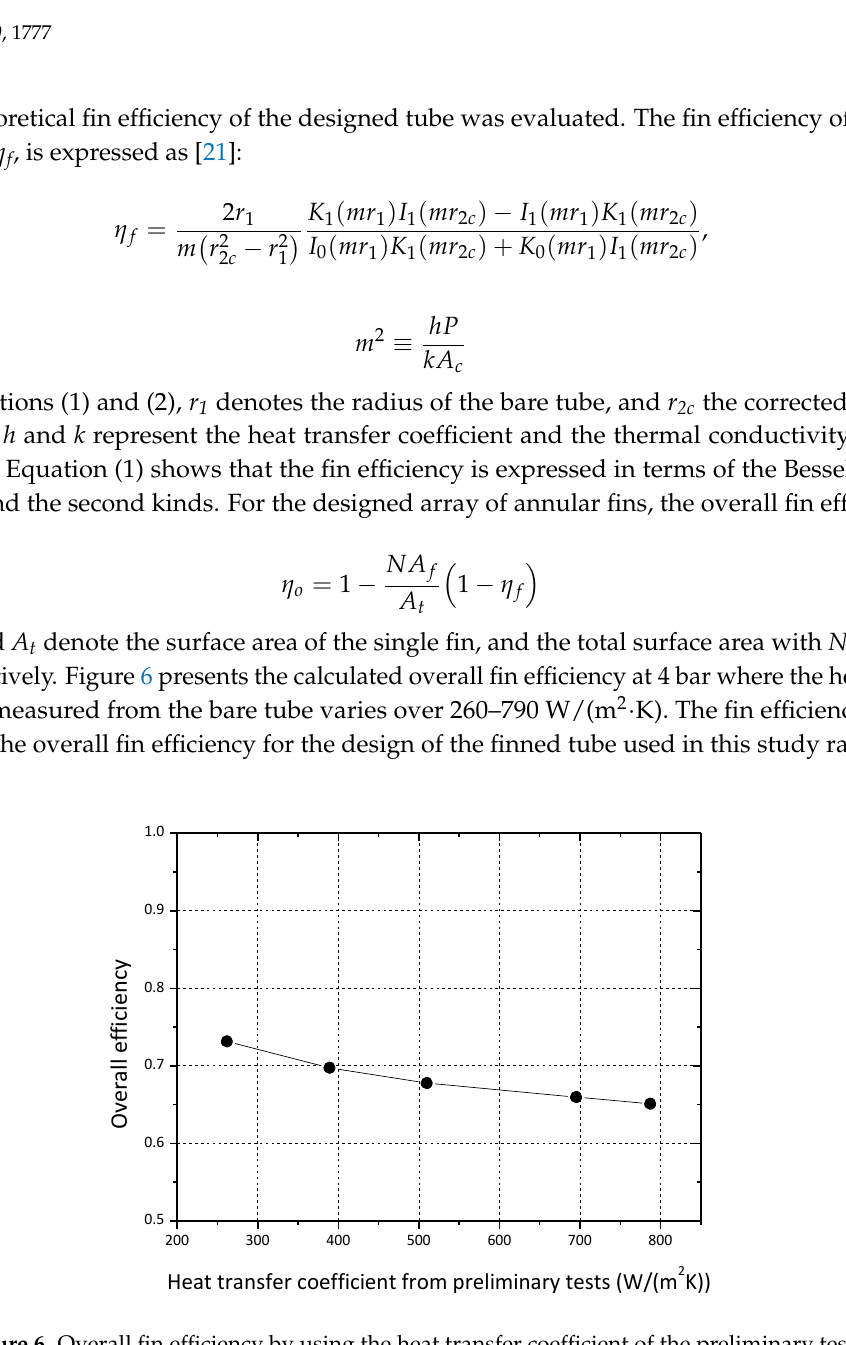
Figure 6. Overall fin efficiency by using the heat transfer coefficient of the preliminary test.